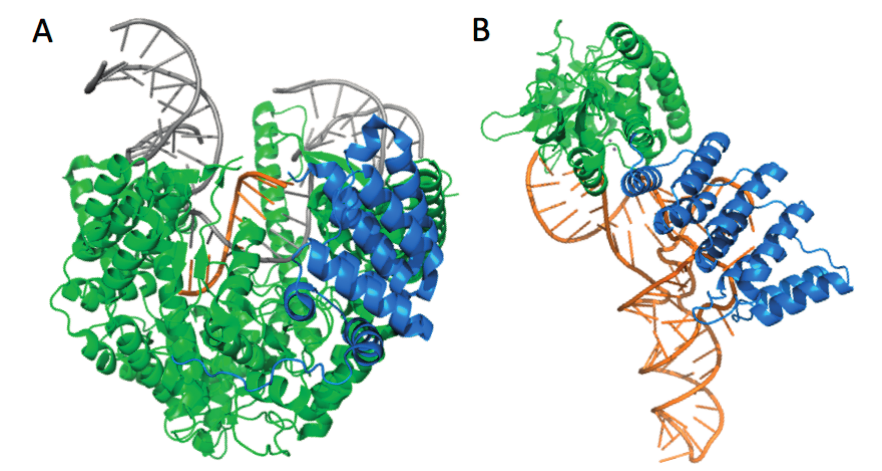
Figure 5. Many factors required for mitochondrial gene expression, i.e. , for the biogenesis of tRNA belong to the super-family of helical repeats modular proteins [170]. In particular, key factors for tRNA biogenesis in mitochondria belong to the PPR family. ( A ) Experimental structure of human mitochondrial RNA polymerase elongation complex and ( B ) model of Arabidopsis mitochondrial RNase P (AtPRORP1) in complex with mitochondrial tRNA Cys , with PPR domains highlighted in blue. RNA molecules are shown in orange and DNA in grey. The functions of the respective PPR domains are related to the exit of newly transcribed RNA molecules [147] and to the specific recognition of tRNA precursors